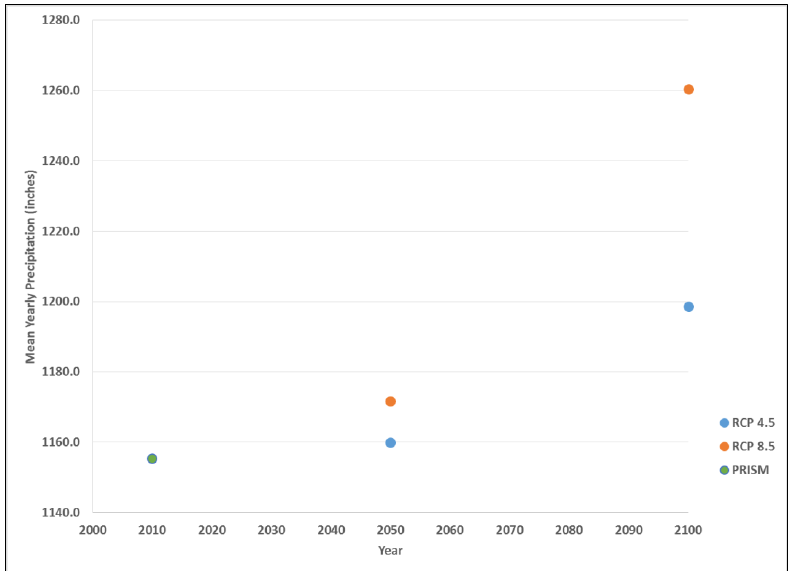
Figure 3. Historical and predicted average annual precipitation levels across Maine, U.S. displayed as 30 years normal using PRISM data (1990), RCP 4.5 (2050, 2100) and RCP 8.5 (2050, 2100). Precipitation estimates follow this same trend, with an historic mean annual (30-year normal) value of 1155 mm in 1990 (Figure 3). The projected mid-century mean precipitation under RCP 4.5 was 1160 mm, increasing by the end of the century to 1199 mm. The projected mean precipitation under RCP 8.5 was 1172 mm, increasing by the end of the century to 1260 mm, which represents the greatest change in a 30-year period considered in this analysis (Figure 4). Figure 4. Thirty year normal minimum and maximum temperature for: PRISM data (1990), RCP 4.5 (2050, 2100), and RCP 8.5 (2050, 2100).